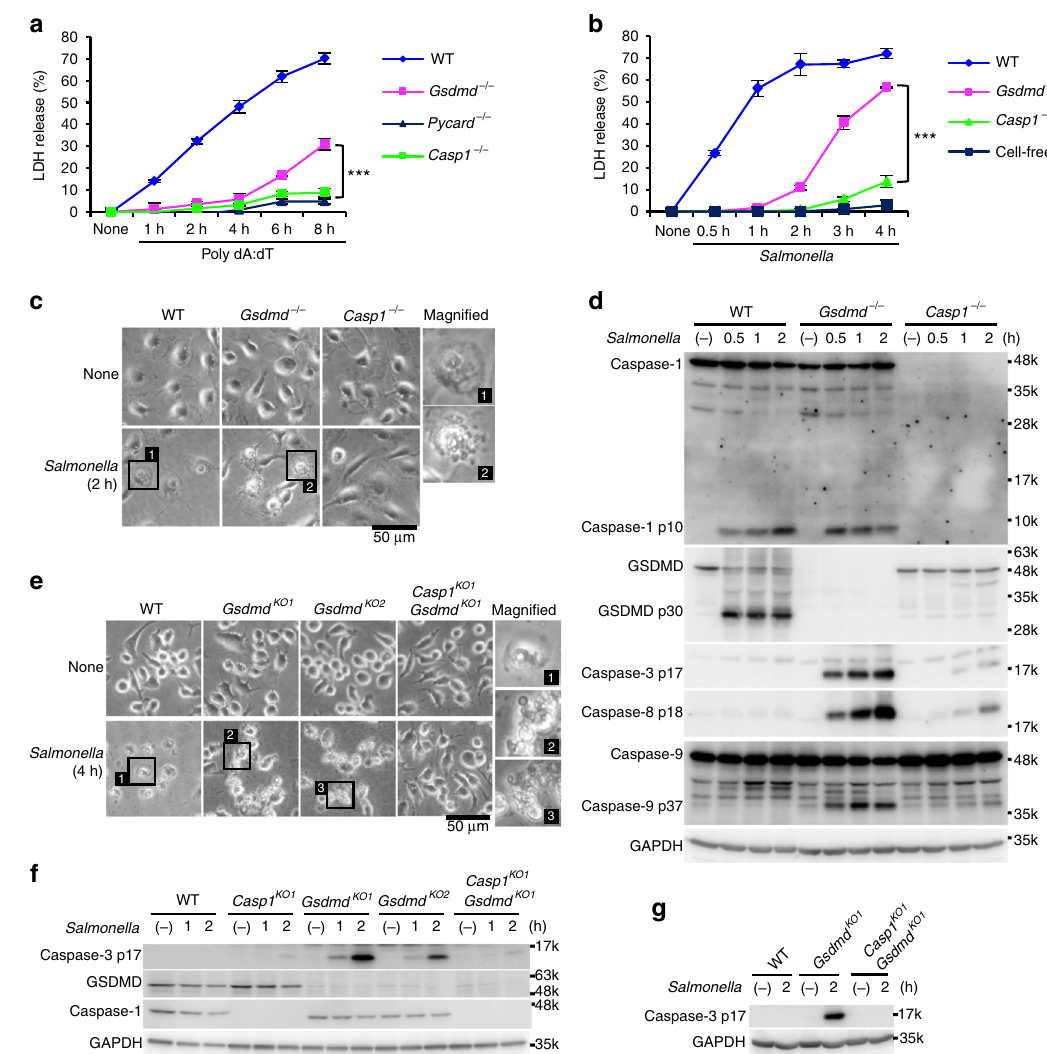
Fig. 1 GSDMD-de fi cient macrophages undergo apoptosis after in fl ammasome activation. a – d TEPMs ( a ) and BMMs ( b – d ) of the indicated genotypes were transfected with 150 ng of Poly dA:dT ( a ) or infected with S . Typhimurium at an MOI of 5 ( b – d ). Bacteria were washed out ( c ) or not washed out ( b , d ), and gentamicin was added to the BMM cultures at 1 h after infection. Cell death was monitored by LDH release assay ( a , b ). Graphs depict the mean ± SD of triplicate cultures. *** p < 0.001 (Bonferroni ’ s multiple comparisons test). Microscopic images ( c ). Western blot detection of activated caspases in culture supernatants plus cell lysates (Sup + CL) ( d ). e – g RAW264.7 cells of the indicated genotypes were infected with S . Typhimurium at an MOI of 40. Bacteria were washed out, and gentamicin was added to the cultures at 2 h after infection ( e ). S . Typhimurium-infected Gsdmd -KO RAW264.7 cells showed apoptotic morphological changes. Western blot detection of caspase-3 p17 in cell lysates ( f ) and Sup + CL ( g ). Data are from one representative of three biologically independent experiments with similar results ( a – g ). Source data are provided as a Source Data fi le. (See also Supplementary Figs. 1 and